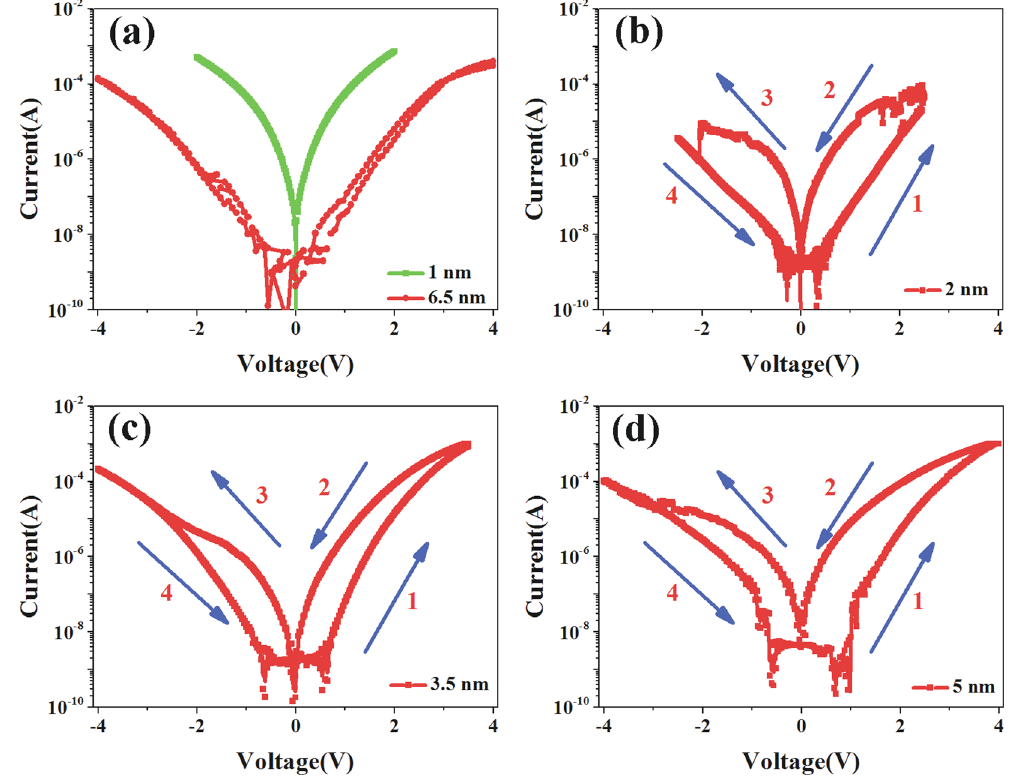
Figure 3. I - V characteristics of Pt Pt/BFO/SiO x /Si with different thick BFO films: ( a ) 1 nm and 6.5 nm thick BFO films; ( b ) 2 nm thick BFO film; ( c ) 3.5 nm thick BFO film; ( d ) 5 nm thick BFO film. The blue arrows show the direction of voltage